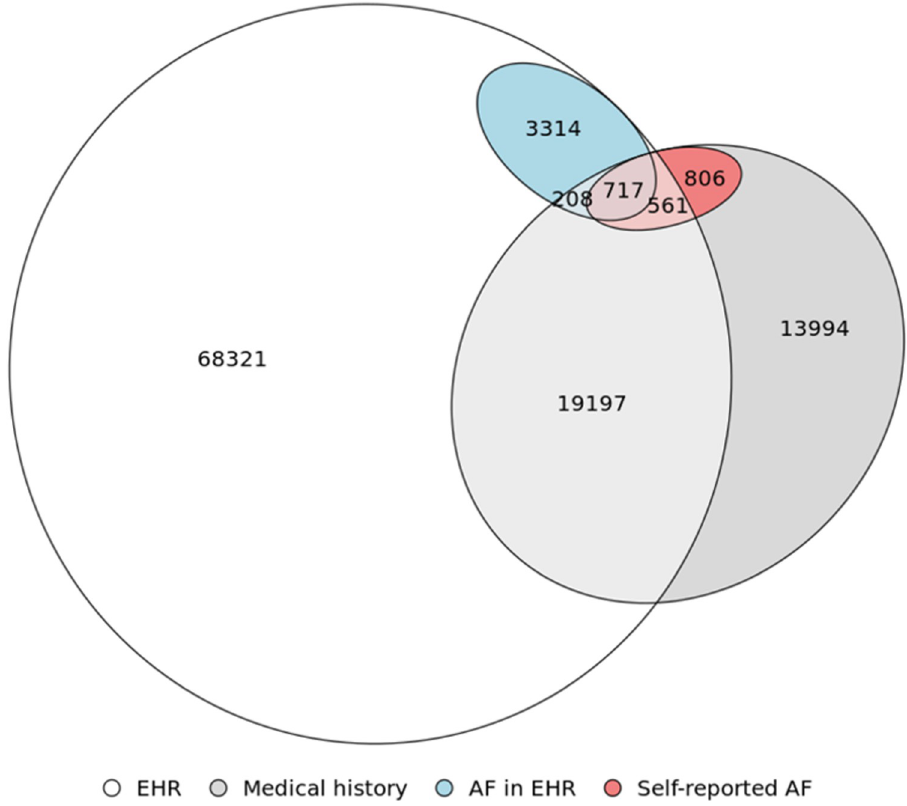
Fig 2. Venn diagram representing overlap of participants with EHR data, medical history survey data, those with AF in the EHR, and those with self-reported AF in the medical history survey, All of Us Research Program, 2017– 2019. The intersection of these variables leads to eight different groups: (1) among participants with both EHR and medical survey, those with AF in the EHR and the medical survey (n = 717), AF in the medical survey but no in the EHR (n = 561), AF in the EHR but not in the medical survey (n = 208), and no AF in any data source (n = 19,197); (2) among participants with EHR but not medical survey, AF in the EHR (n = 3,314) and no AF (n = 68,322); and (3) among participants with medical history survey but not EHR, AF in the medical survey (n = 806) and no AF (n = 13,994). The diagram does not include 65,982 participants with neither EHR nor medical history survey.